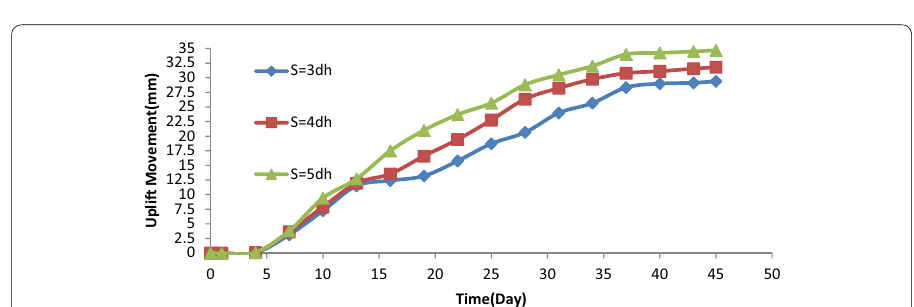
Fig. 23 Variation of uplift movement with time for pile group of L/D